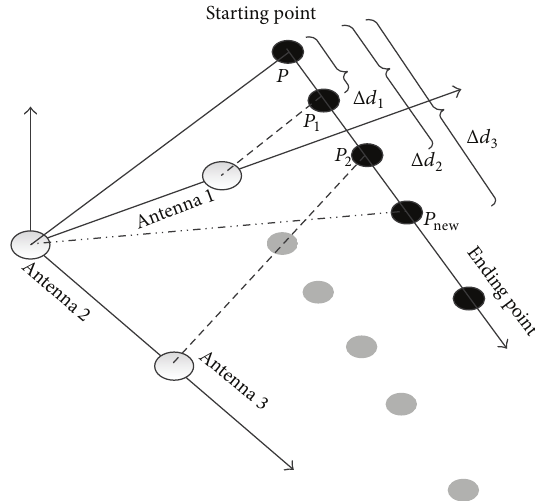
Figure 2: Schematic description of the geometry of three antennas and the position of radiation